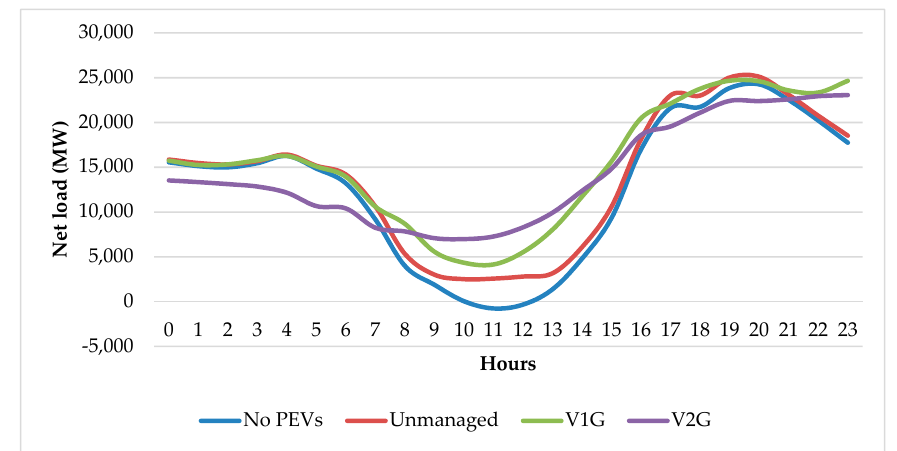
Figure 7. California Managed Charging: April 2030—Mid Scenario—Ramp-Rate Mitigation. Estimated Avoided Needs for Grid Storage